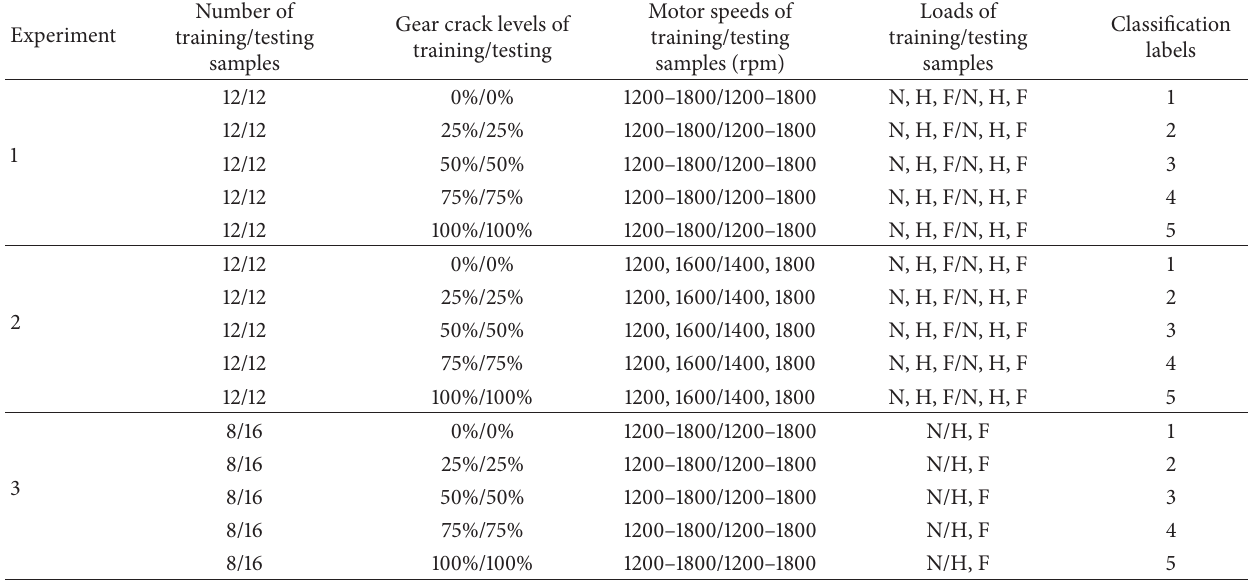
Table 2: The design of the three experiments (N, H, and F denotes no load, half load, and full load, resp.). Experiment